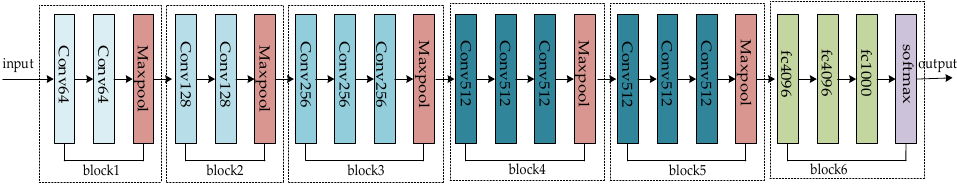
Figure 6. VGG16 network structure.